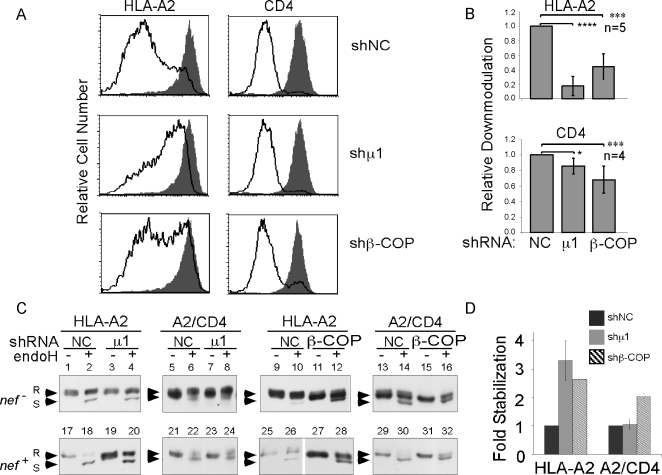
Nef requires β-COP to reduce HLA-A2 cell surface expression
and accelerate HLA-A2 degradation.(A) β-COP and μ1 are required for Nef to reduce cell
surface expression of HLA-A2. CEM HA-HLA-A2 cells were transduced with a
lentivirus expressing GFP and a control (shNC), β-COP
(shβ-COP) or μ1 (shμ1) shRNAs and with control
adenovirus (nef−) or adeno-Nef
(nef+). Cell surface
expression of HLA-A2 or CD4 in the GFP-positive cells was assessed by
flow cytometry. The gray shaded histogram represents control adenovirus
(nef−) treated cells and
the solid black line represents adeno-Nef
(nef+) treated cells. (B)
Quantitation of HLA-A2 and CD4 downmodulation in Nef expressing cells
transduced with shRNA. The median fold downmodulation (median
fluorescence of control/median fluorescence of Nef-expressing
cells)±standard deviation derived from five (HLA-A2) and four
(CD4) independent experiments. A p value was calculated
using a two tailed t-test and significant differences were indicated
with asterisks (*p<0.02,
***p<10−3,
****p<10−4).
(C) Knockdown of β-COP stabilizes intracellular levels of HLA-A2
and A2/CD4 in Nef expressing cells. CEM HA-HLA-A2 and CEM HA-A2/CD4 were
treated as in part A. Lysates from these cells were generated and
treated with endoglycosidase H (endo H). Protein levels of HLA-A2 and
A2/CD4 were assessed by western blot using an anti-HA antibody. Endo
H–resistant bands are marked with an R and endo
H–sensitive bands are marked with an S. The results shown are
representative of three independent experiments for HLA-A2 and two
independent experiments for A2/CD4. (D) Quantification of endo
H–resistant protein. Adobe Photoshop software was used to
quantify each band for the Nef-expressing samples. The percentage of
endo H–resistant protein in each condition was calculated as
follows: [resistant band/(resistant band+sensitive
band)]×100. The fold stabilization was then
calculated as: (% endo H–resistant in experimental
sample)/[% endo H–resistant in control
(shNC)]. The data shown is the mean of two
experiments±standard deviation.